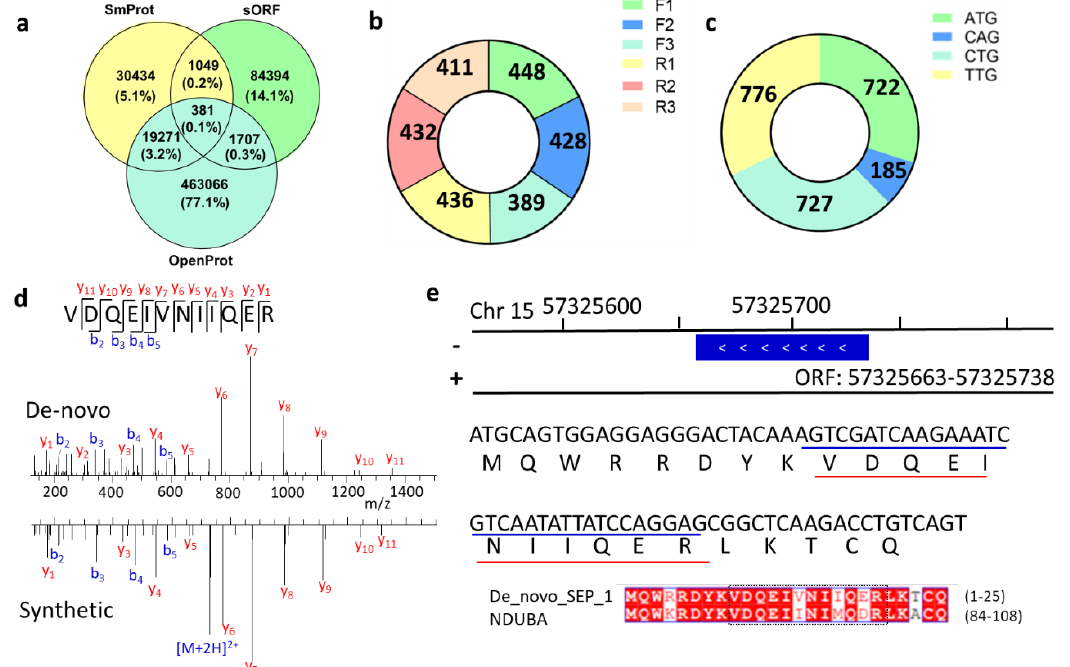
Figure 5. Novel SEPs identified from de novo sequencing. ( a ) Overlap among different SEP databases. ( b ) Distribution of reading frame shift of SEPs. ( c ) Numbers of novel SEPs with different start codons. ( d ) MS/MS spectra of VDQEIVNIIQER peptide. ( e ) Genome location and full sequence of de novo sequencing predicted peptide in ( d ).